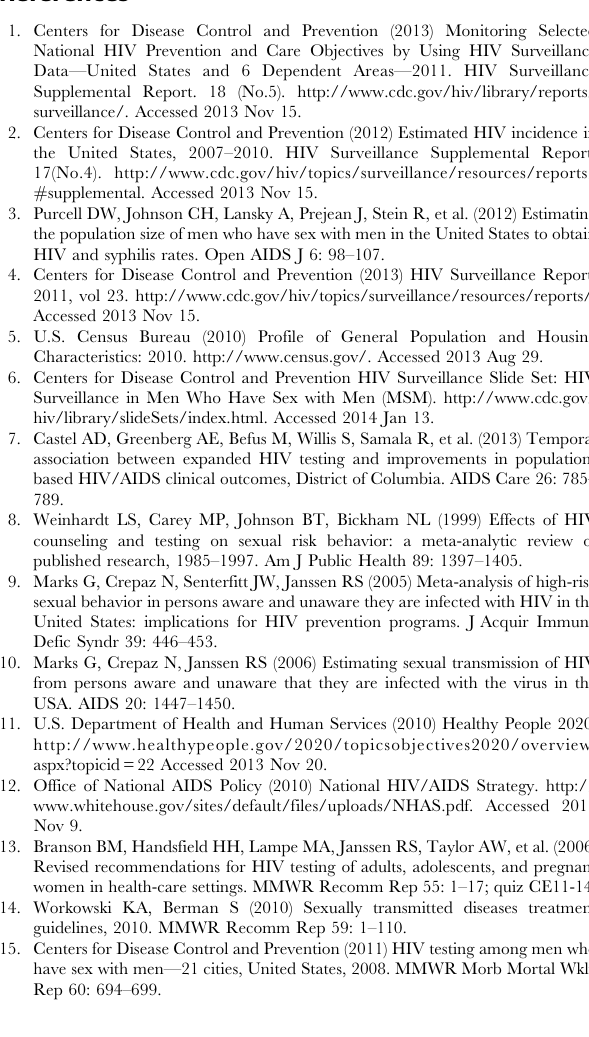
Table S1 National HIV Behavioral Surveillance System (NHBS): Local institutional review boards (IRBs) by Metropolitan Statistical Area